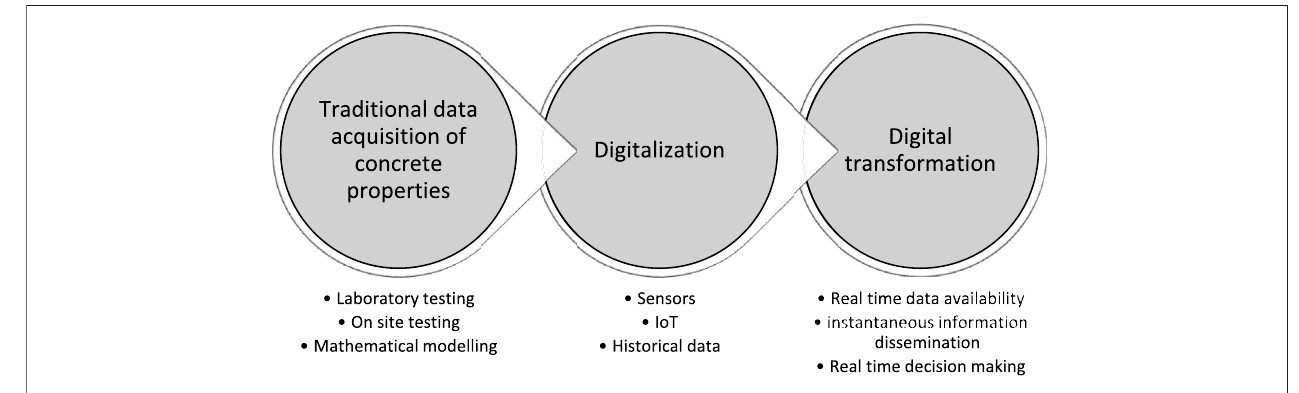
FIGURE 3 | Digital transformation of concrete